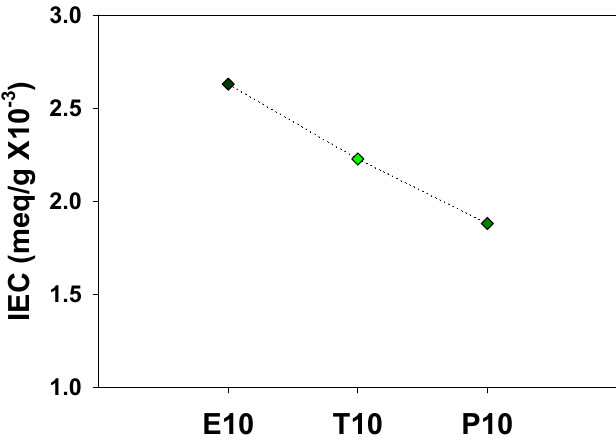
Figure 7. Ion exchange capacity (IEC) of PAMPS membranes.